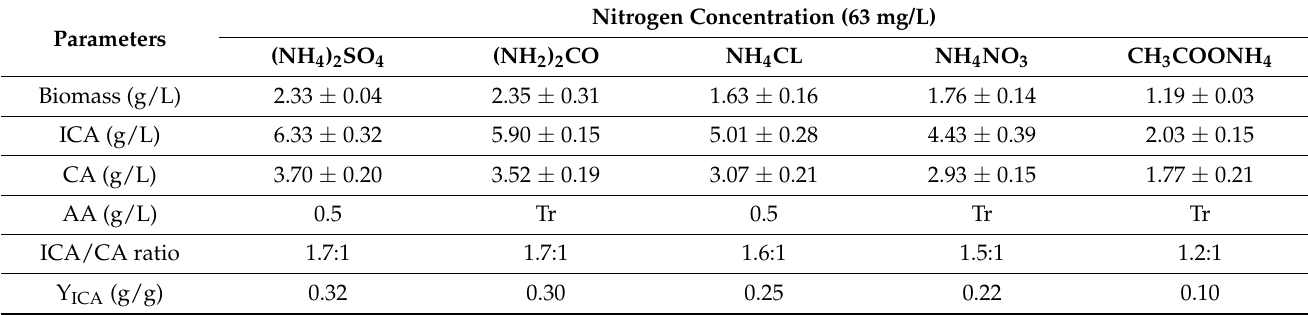
Table 3. Effect of nitrogen source on the growth of Y. lipolytica VKM Y-2373 and ICA production.